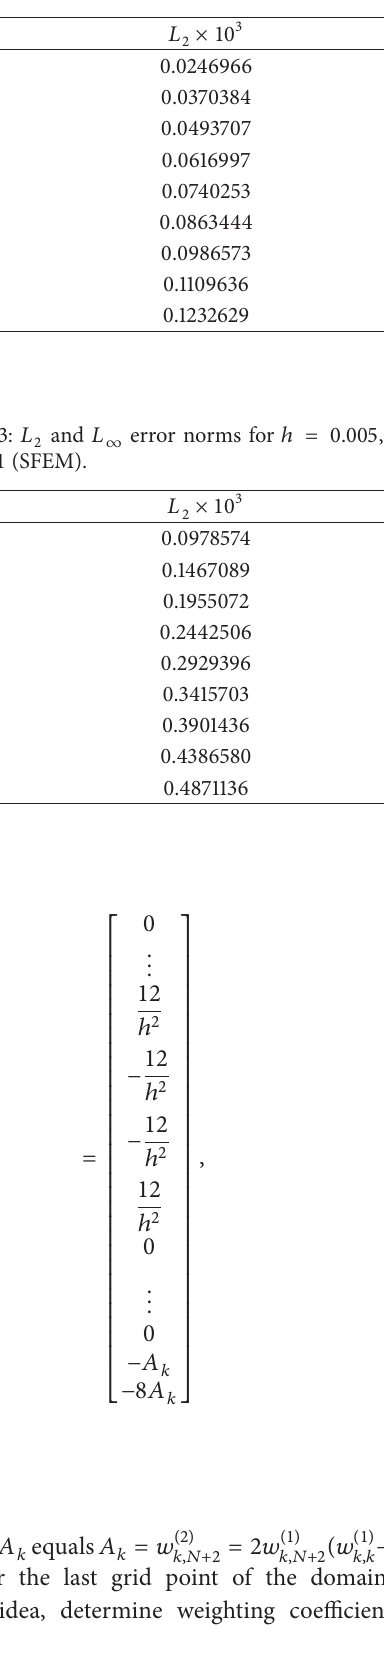
Table 2: 𝐿 2 and 𝐿 ∞ error norms for ℎ = 0.005 , Δ𝑡 = 0.001 , and V = 0.005 (SFEM).